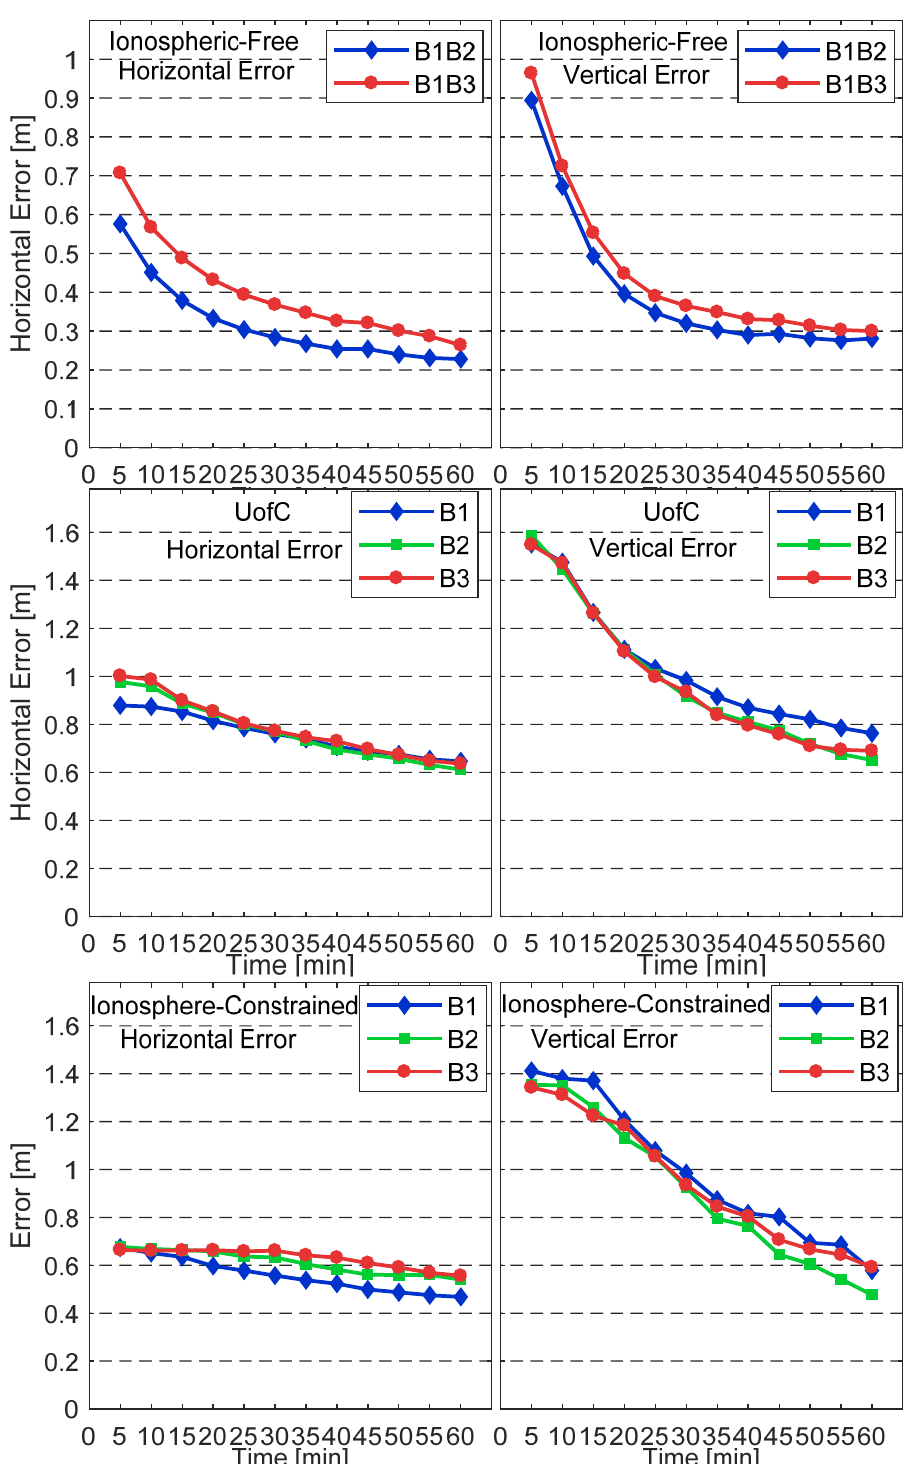
Figure 8. Average convergence time statistics of BDS SBAS corrections-based kinematic DF- and SF-PPP for different schemes.